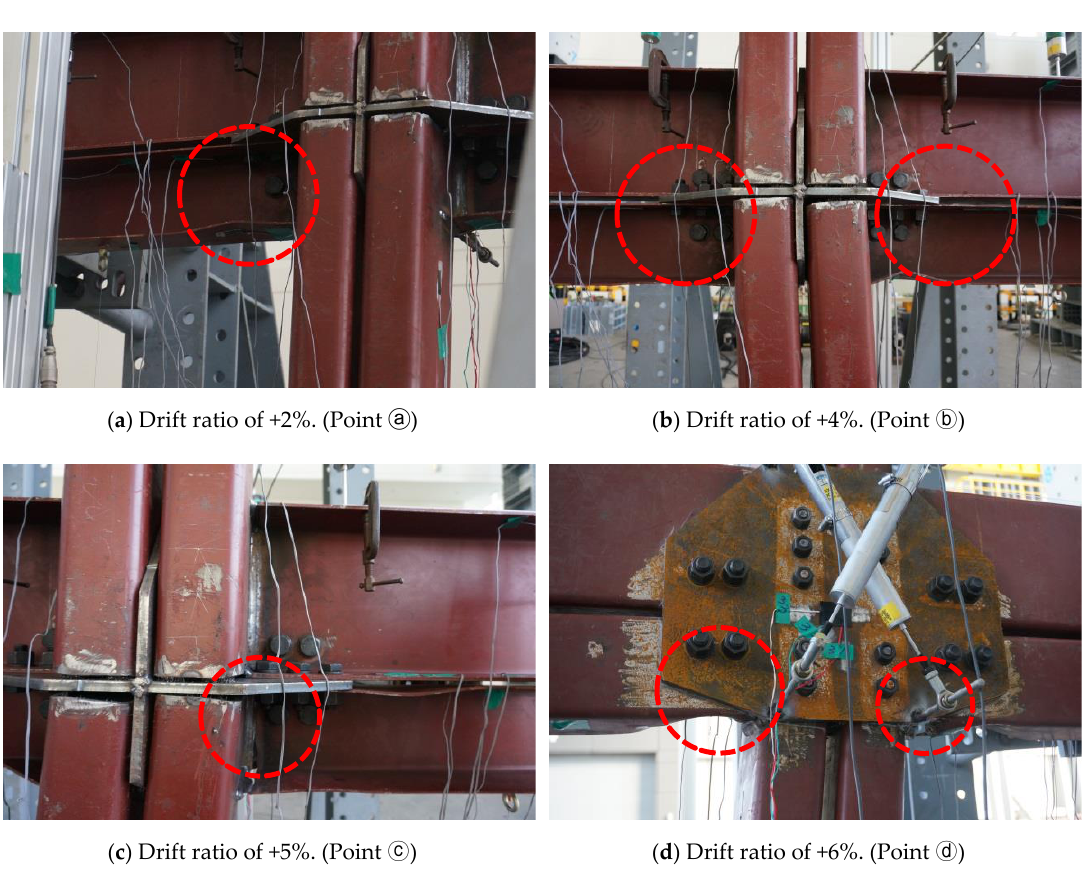
Figure 11. Hysteresis and backbone curves of specimen IC_OB_F.